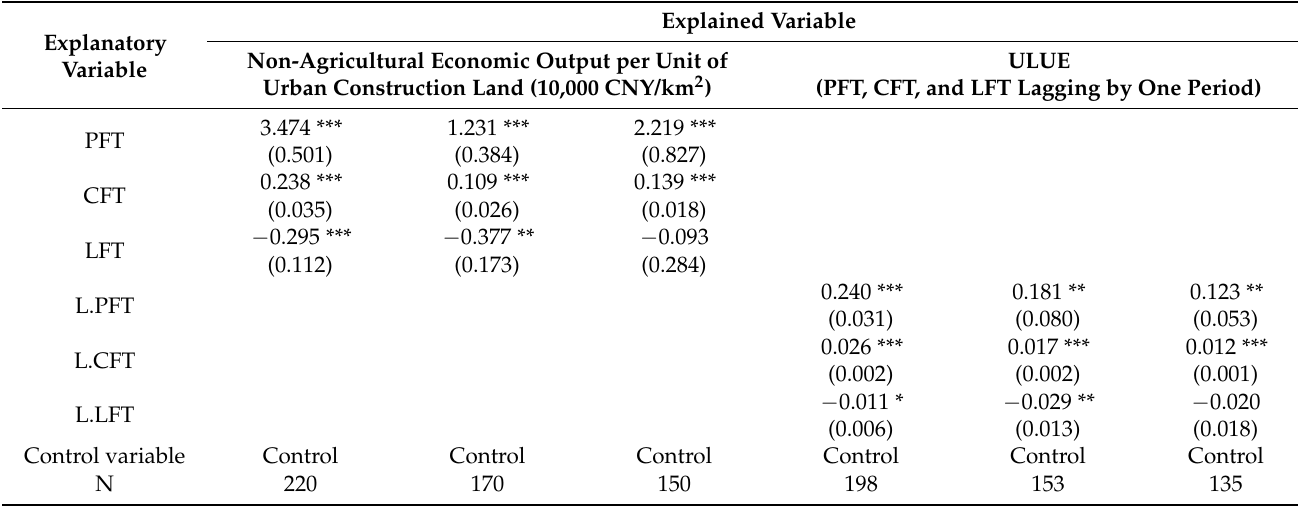
Table 6. Robustness and endogeneity